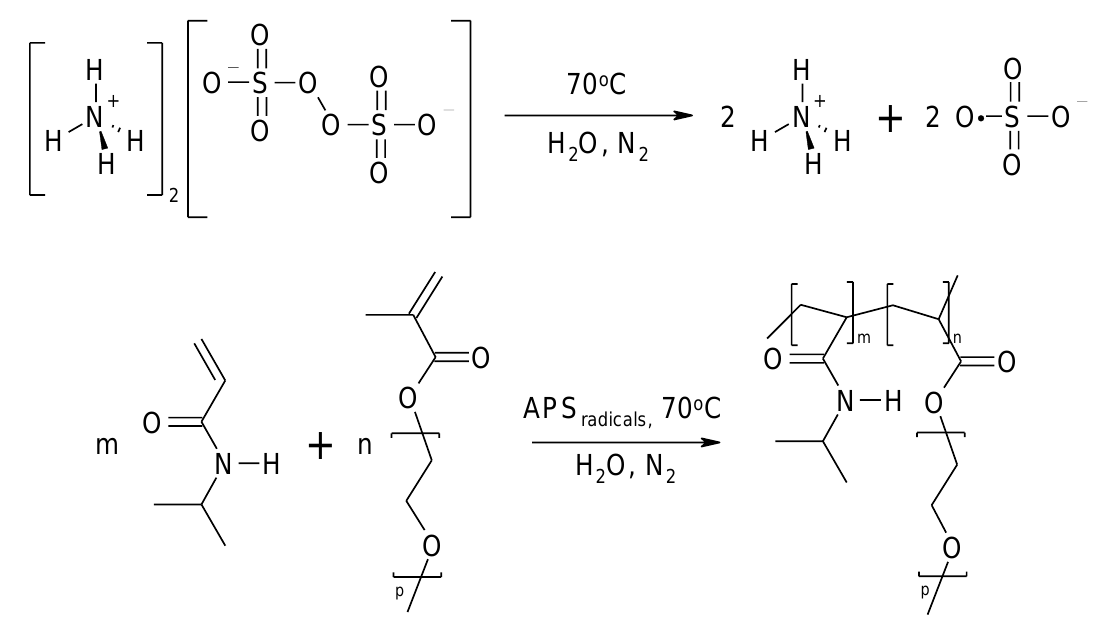
Figure 1. The general scheme of NIPA polymerization with PEGMEM under experimental conditions used in this study.